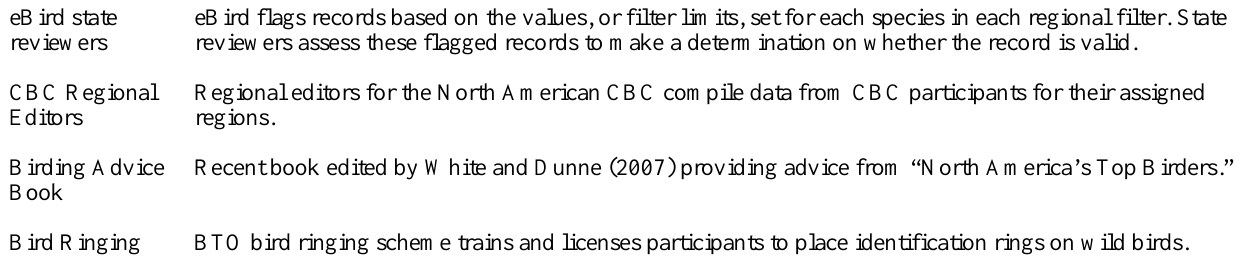
Bird Ringing BTO bird ringing scheme trains and licenses participants to place identification rings on wild birds.